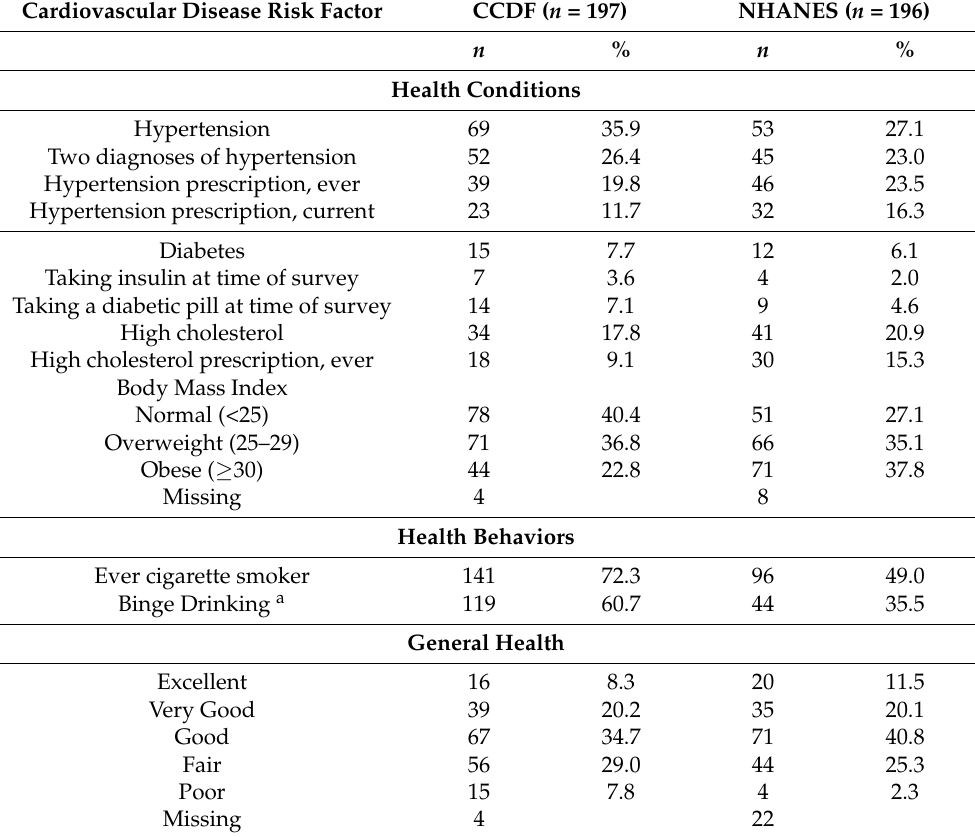
Table 3. Prevalence of cardiovascular disease risk factors among individuals incarcerated in Coconino County Detention Facility and NHANES participants, 2017–2018. Cardiovascular Disease Risk Factor